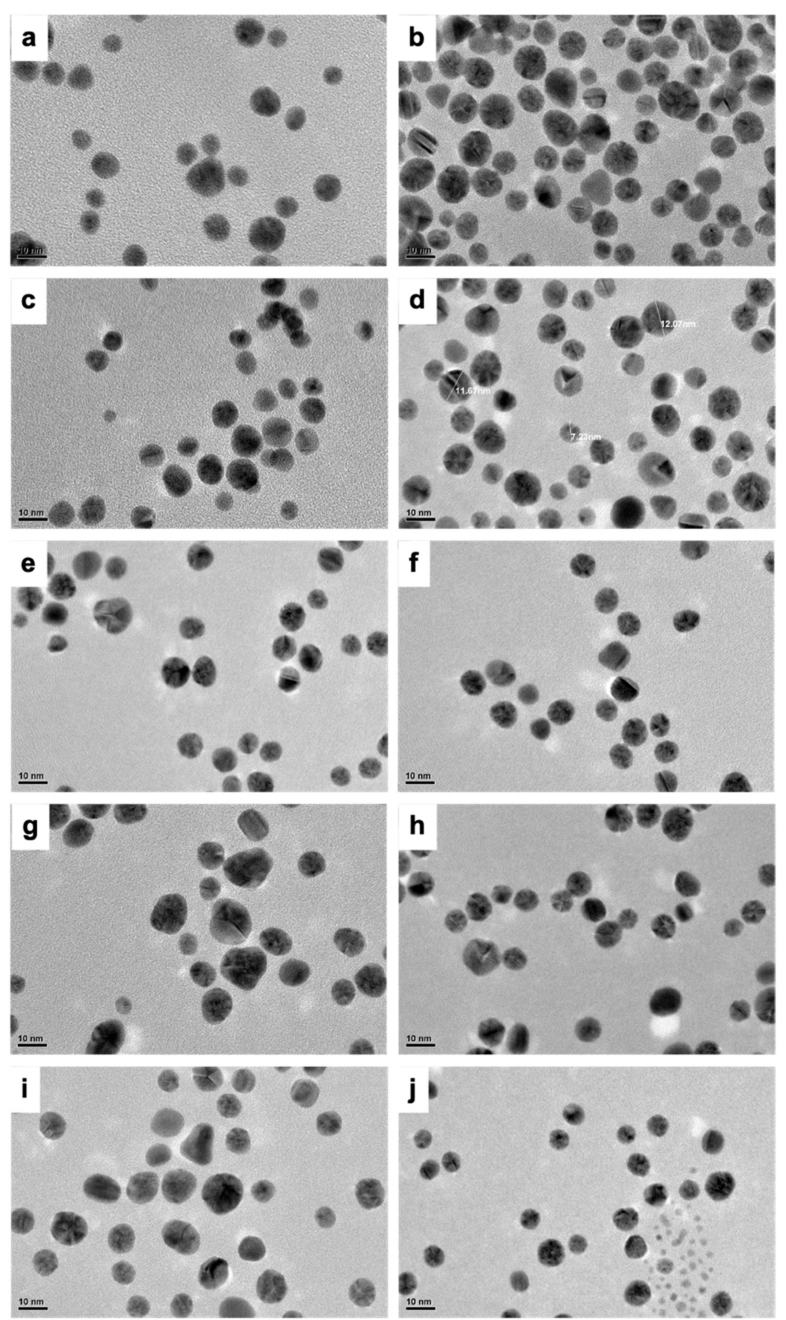
Figure 2. TEM micrographs of the Ch-AuNPs synthesized under various parameters. ( a ) Ch-AuNPI, ( b ) Ch-AuNPII, ( c ) Ch-AuNPIII, ( d ) Ch-AuNPIV, ( e ) Ch-AuNPV, ( f ) Ch-AuNPVI, ( g ) Ch-AuNPVII, ( h ) Ch-AuNPVIII, ( i ) Ch-AuNPIX, ( j ) Ch-AuNPX. It could be observed that though there is a slight diversity in shape and size of the NPs, overall, the NPs are uniform in their morphological features. (scale bar = 10